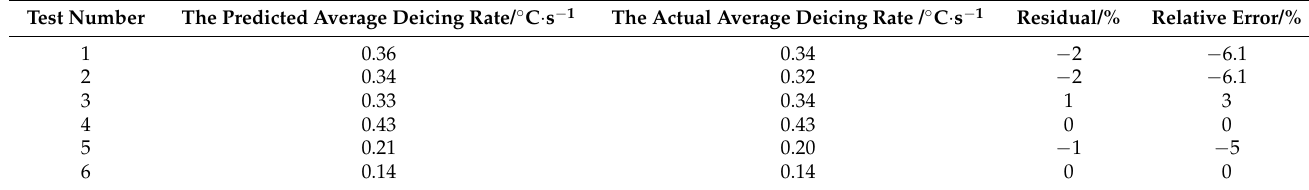
Table 7. Prediction results and test truth values of average deicing